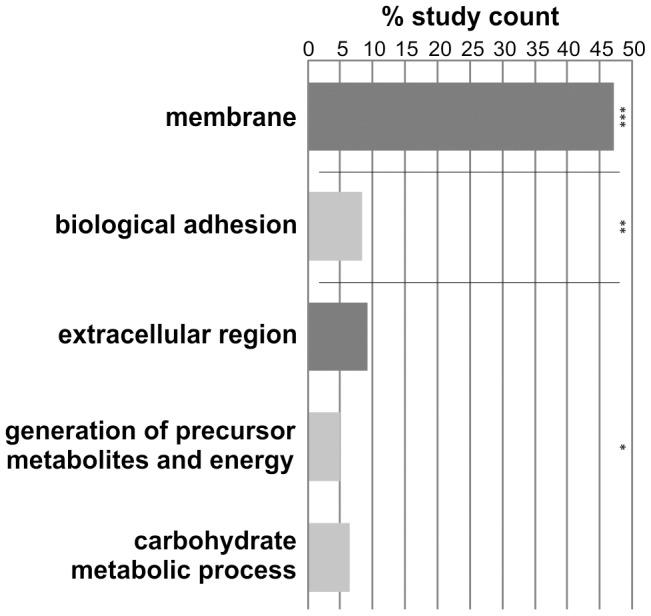
GO for genes differentially regulated according to the microarray analysis.This analysis was performed for genes significantly and differentially transcribed between EM and UM. For transcripts up-regulated in EM, no significantly enriched GO-categories were found. Shown are those categories significantly enriched (% study count) within the data set of genes up-regulated in UM. Light grey: biological process; Dark grey: cellular component; p-values for the GO-analysis: *p<0.05, ** p<0.005, *** p<0.0001.